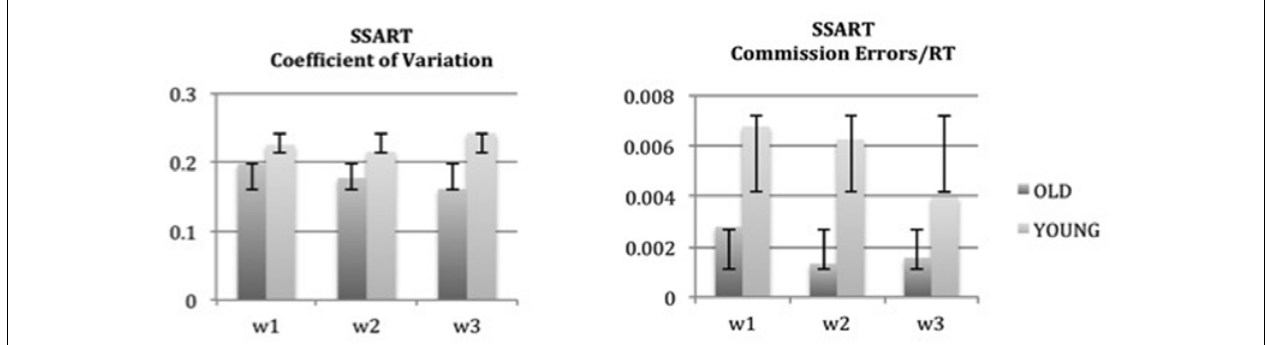
FIGURE 3 |Absence of learning effects in the Shapes Sustained Attention to ResponseTask (SSART). Mean scores and standard deviations of each assessment are reported for coefficient of variation and commission